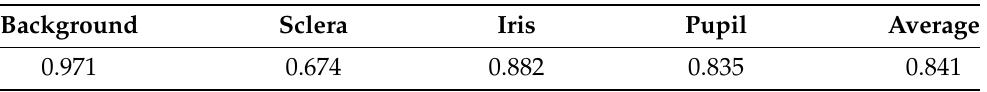
Table 5. Baseline performance (mIoU) for sparse semantic segmentation without the use of tempo- ral information.